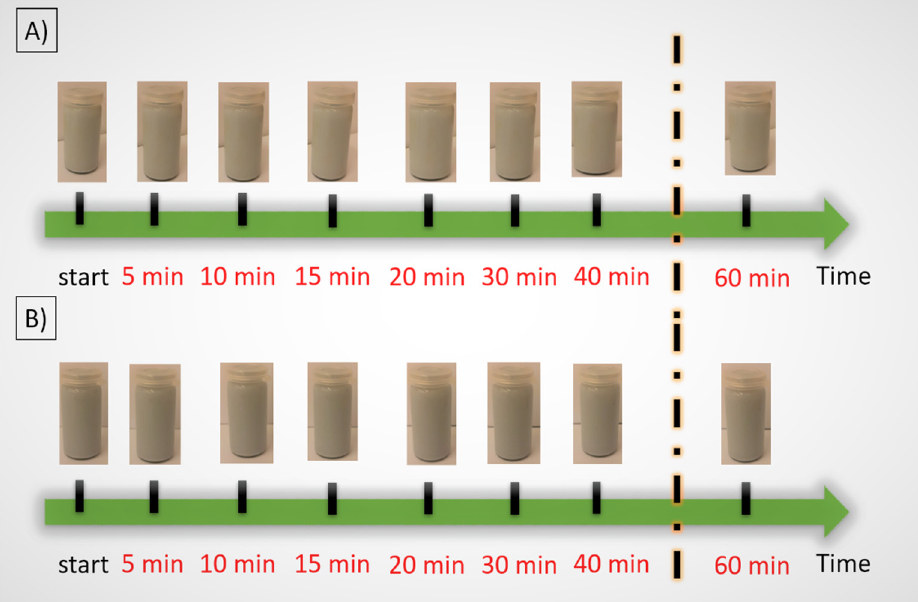
Figure 4. Macroscopic observation of the slurries, ( A ) containing 35 vol.% (Series I) and ( B ) 50 vol.% (Series II) solid phase.